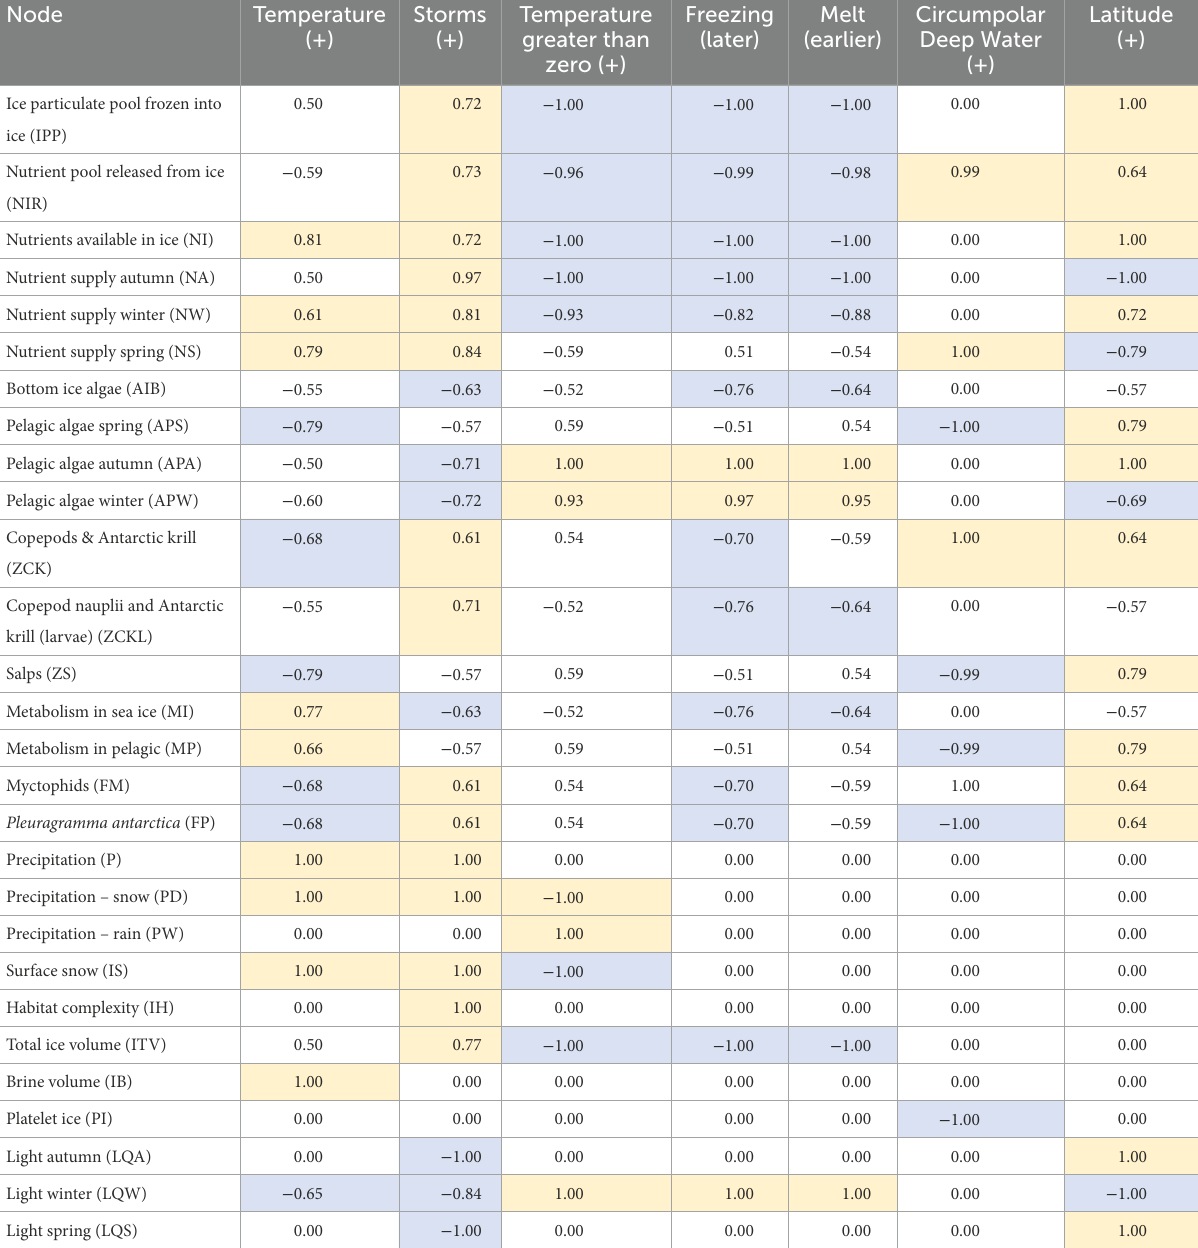
TABLE 3 Assessment of the impacts of key physical drivers of change on the magnitude of food web components associated with sea ice, based on the Qualitative Network Modelling.